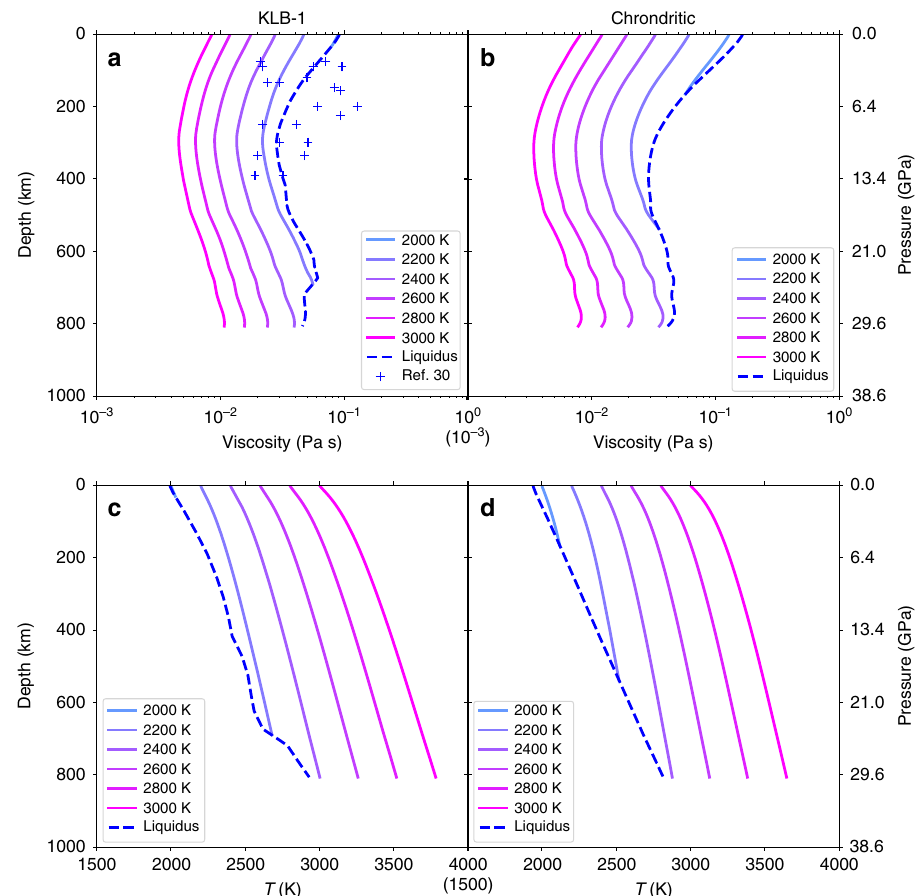
Fig. 3 Change of magma ocean viscosity with depth. a , b We report MO viscosities with KLB-1 (left) and chondrite-type (right) compositions for potential surface temperatures from 2000 to 3000 K. Solid and dashed lines are calculated along mantle adiabats and liquidus pro fi les, respectively. c , d Solid and dashed lines represent adiabatic 63 and liquidus 55,56 pro fi les, respectively, for molten KLB-1 and chondrite-type mantle